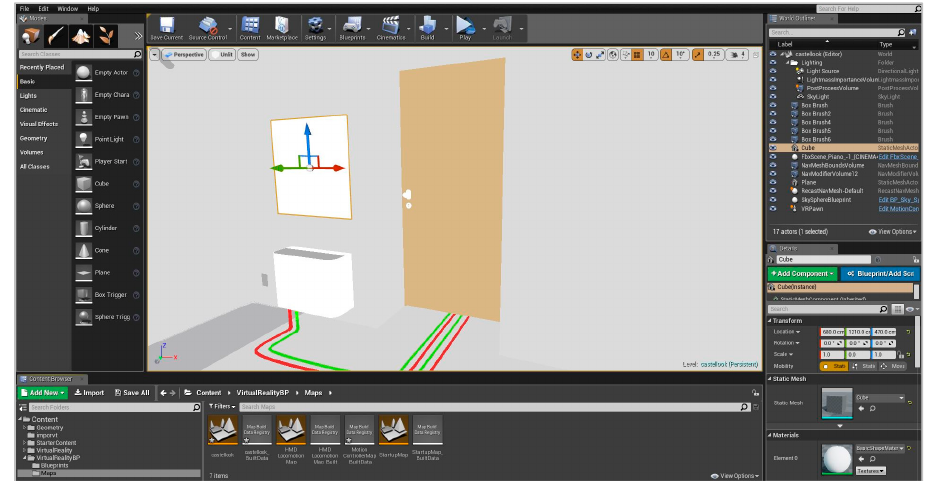
Figure 12. Positioning of a surface close the terminal in Unreal Engine.